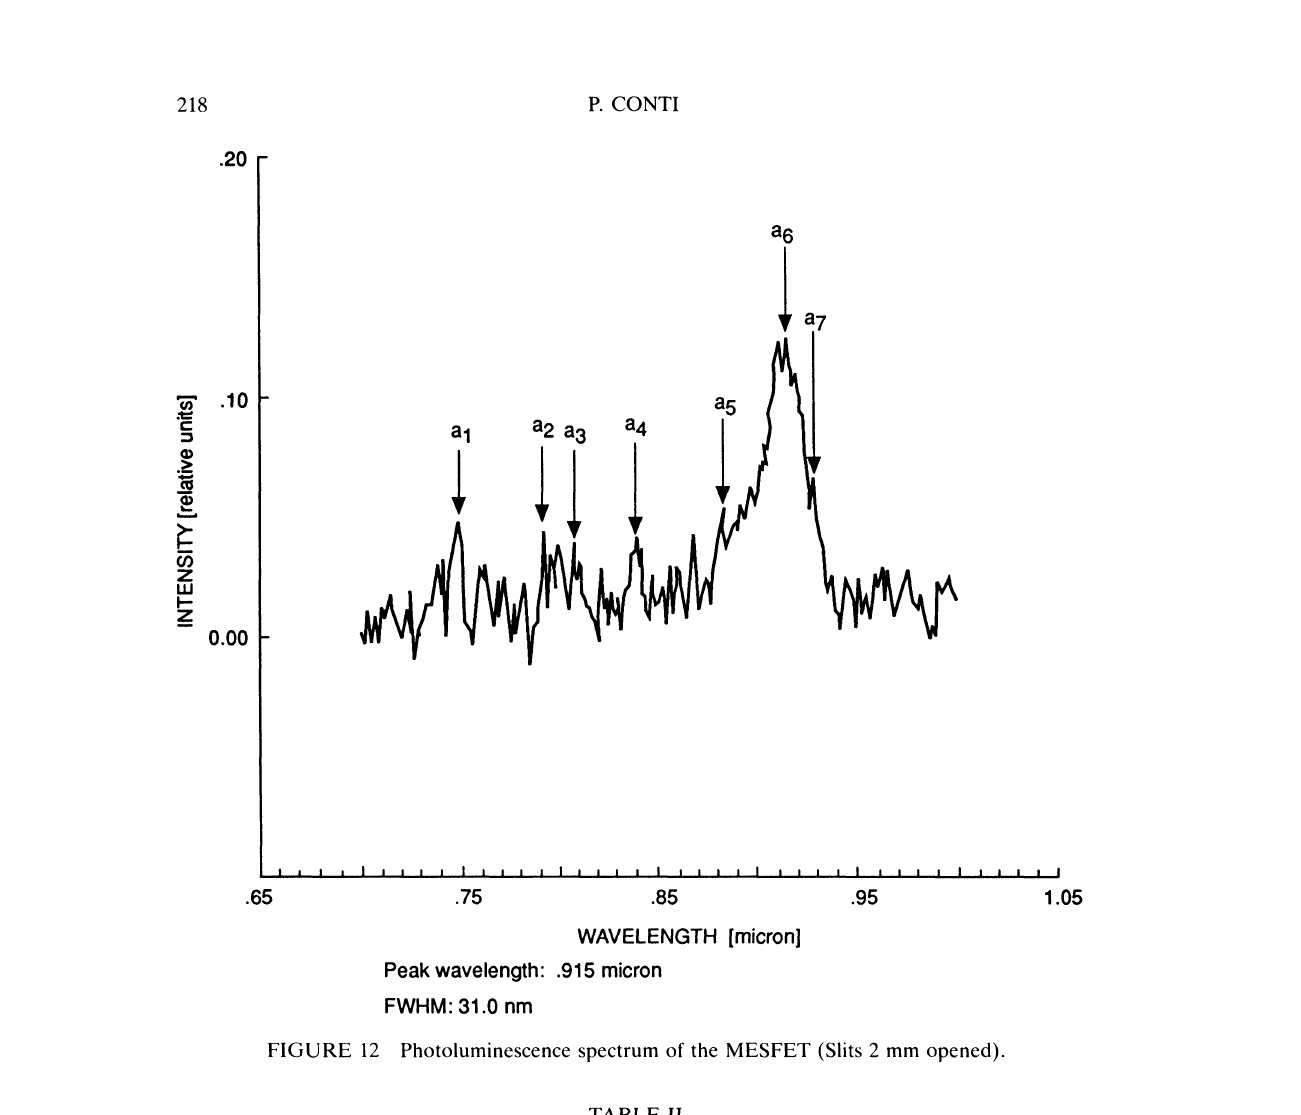
FIGURE 12 Photoluminescence spectrum of the MESFET (Slits 2 mm opened).